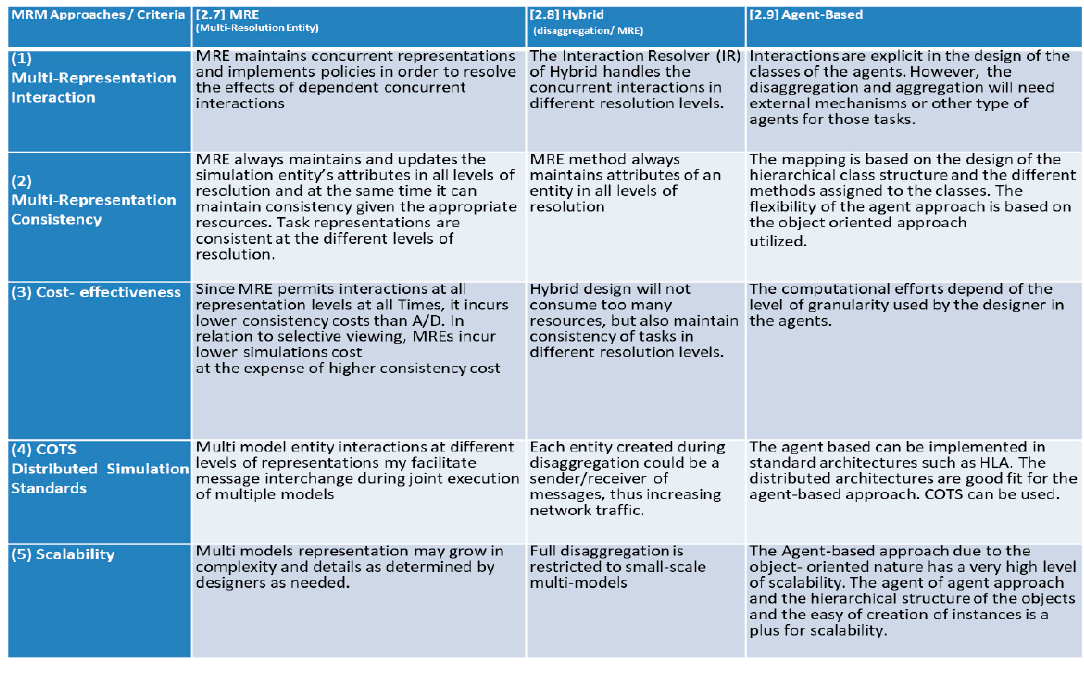
Figure 6. Third Group.